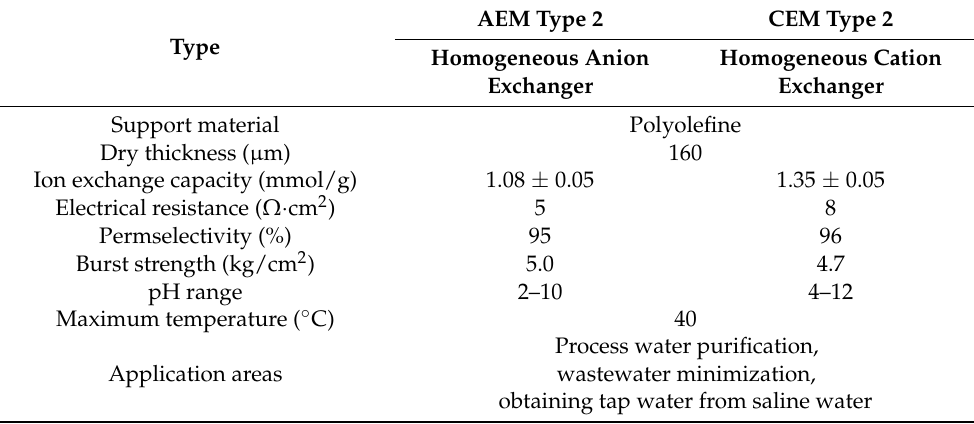
Table 3. Specifications of Fujifilm ion exchange membranes